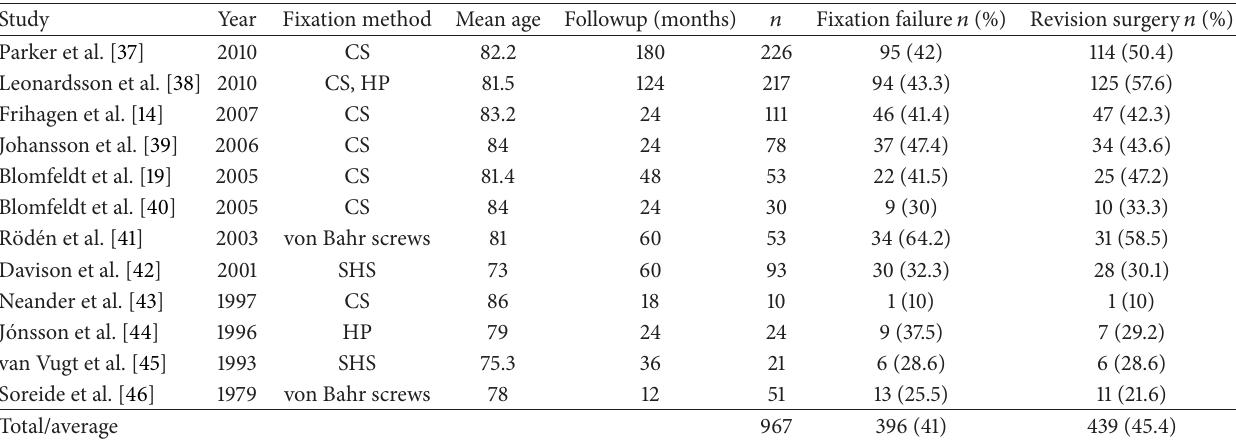
Table 2: Incidence of fixation failure and reoperation in displaced fractures of the femoral neck (Garden III and IV). All patients > 60years. Study Year Fixation method Mean age Followup (months) 𝑛 Fixation failure 𝑛 (%) Revision surgery 𝑛